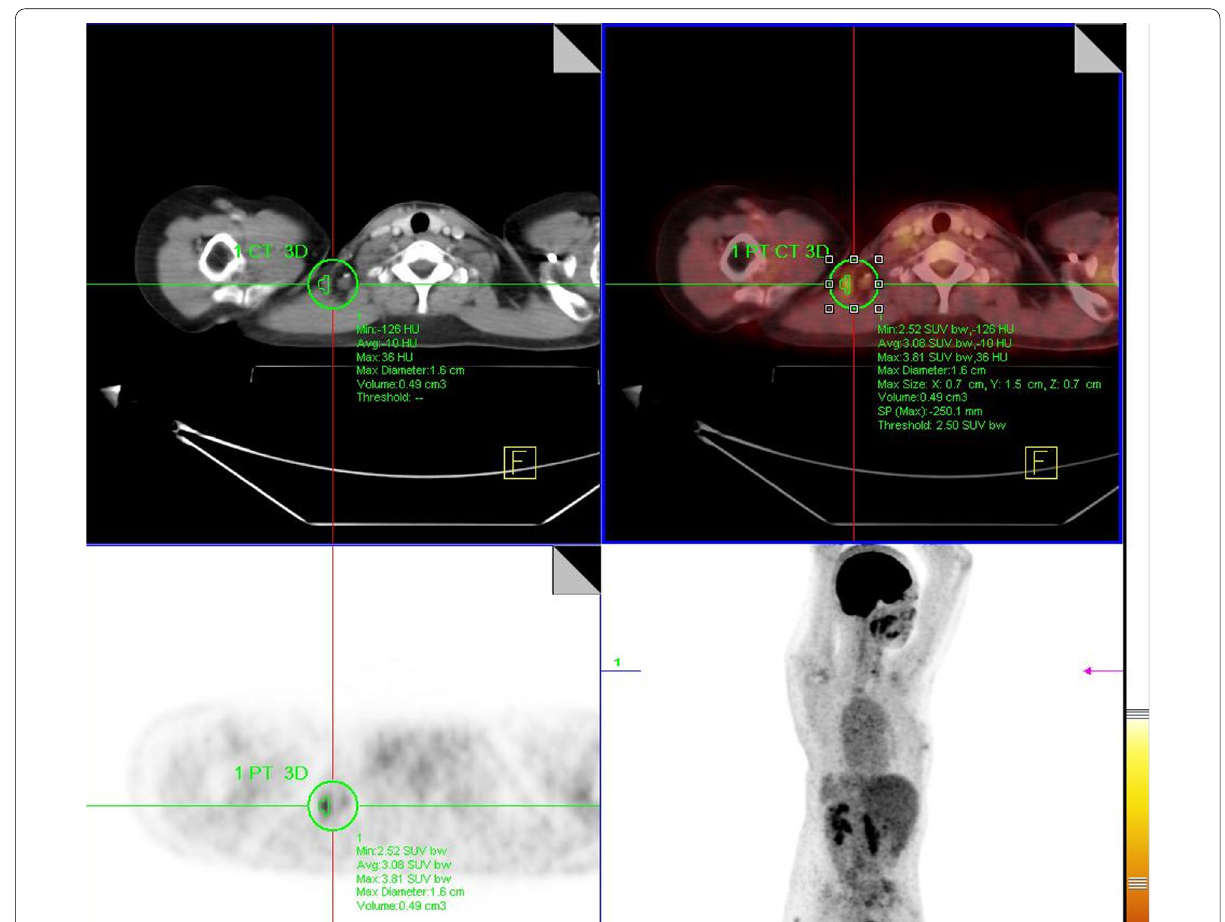
Fig. 9 Axial CT, PET and MIP Fused PET-CT. Fifty-year-old female with history of right mastectomy. There was a recurrent right supraclavicular lymph node tumor on re-staging (stage IIIC)